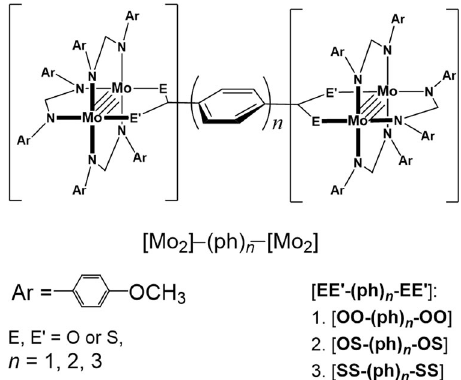
Fig. 1 A molecular scaffold for the complexes under investigation.